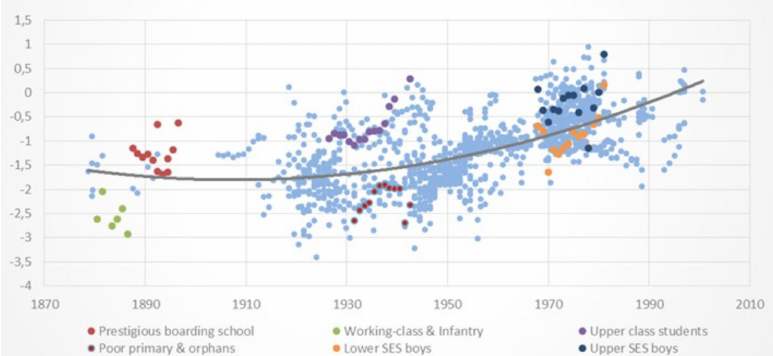
Figure 2. Height-for-Age Z scores (HAZ) of samples of Chilean boys and girls by birth cohorts (1877 − 2001). The six selected samples of boys of upper (three) and lower (three) socioeconomic status described in Table 1 are highlighted against the background of the full